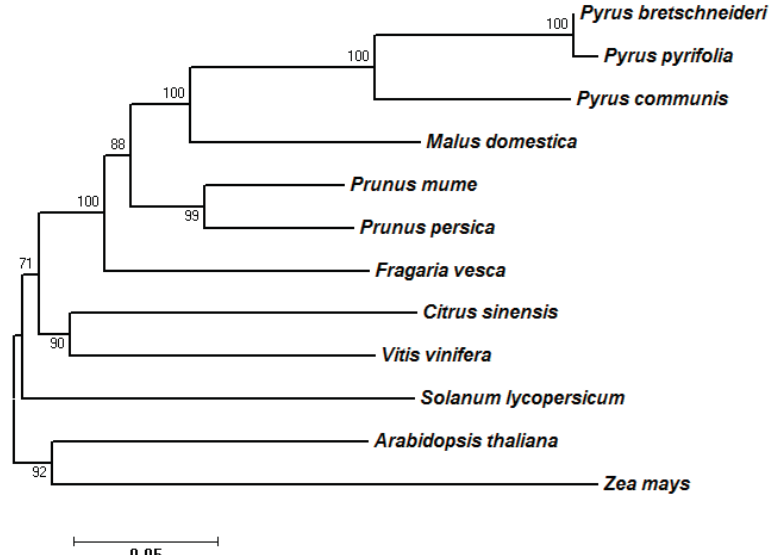
Figure 2. Species tree of seven Rosaceae species and five non-Rosaceae plant species. The protein sequences of different species were first grouped by using OrthoMCL, then sequences in each group were aligned by using Muscle. The tree was constructed by using Molecular Evolutionary Genetics Analysis version 6 (MEGA6) [19] following the ML (maximum likelihood) statistical method and the LG (Le and Gascuel) with Freqs. (+F)